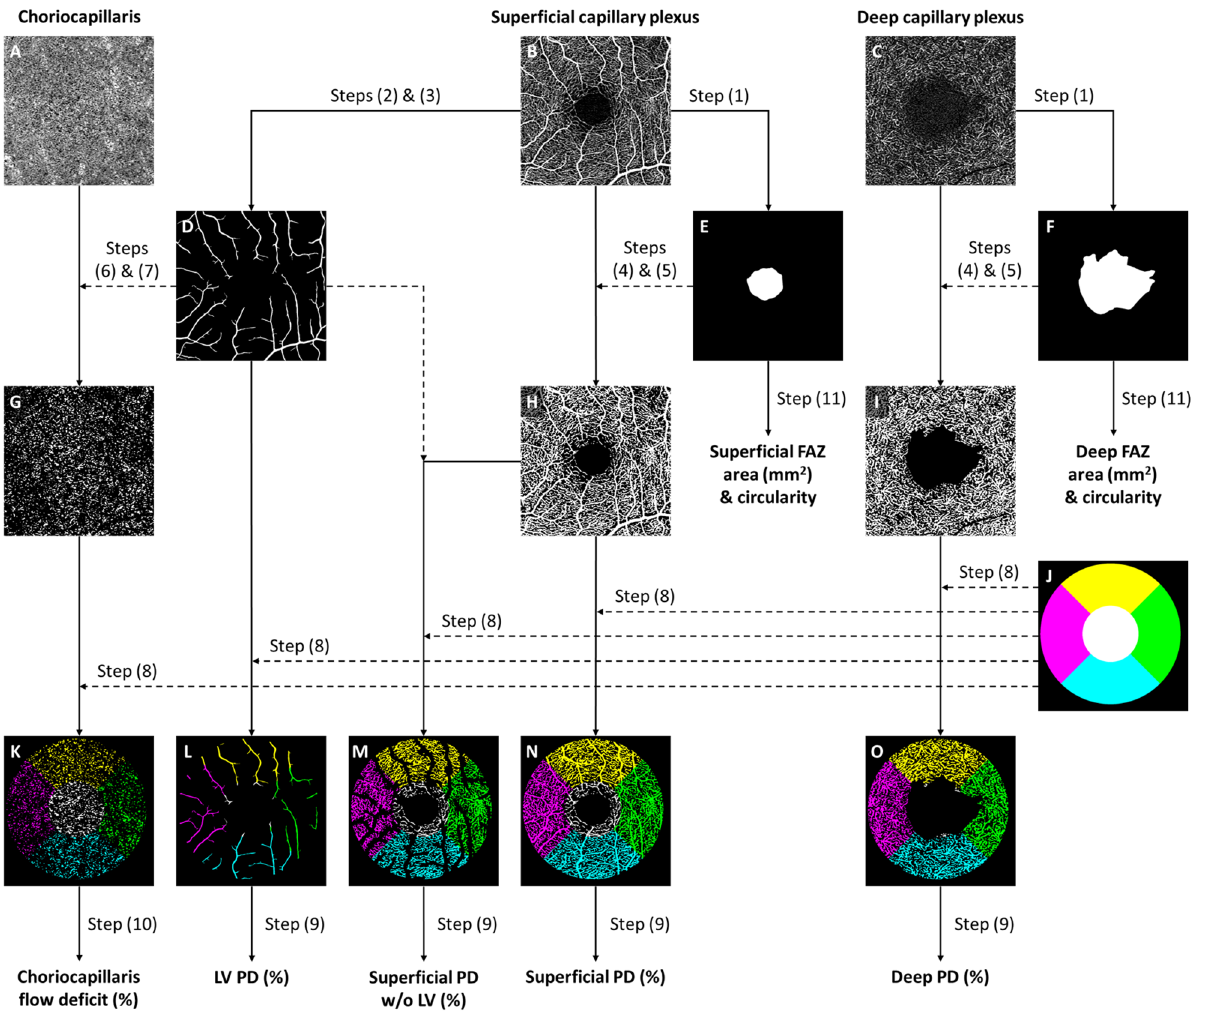
Figure 1. The framework of optical coherence tomography angiography (OCTA) image post-processing. ( A – C ) Raw OCTA images extracted from the OCTA machine. ( D ) Large vessels (LV) segmented and binarized from the superficial capillary plexus. ( E , F ) Foveal avascular zones (FAZ) manually delineated from the superficial and deep capillary plexuses. ( G ) Choriocapillaris flow voids binarized from the OCTA image. Large vessel artefacts were masked before binarization. ( H , I ) Vessels binarized from the superficial and deep capillary plexuses. FAZ regions were masked from the binarized images. ( J ) A magnification-corrected fovea-centered annulus mask with inner diameter of 1.0 mm and outer diameter of 2.5 mm. ( K ) Binarized choriocapillaris flow voids overlaid with annulus mask to perform regional quantification of flow deficit. ( L – O ) Binarized vascular images overlaid with annulus mask to perform regional quantification of perfusion density